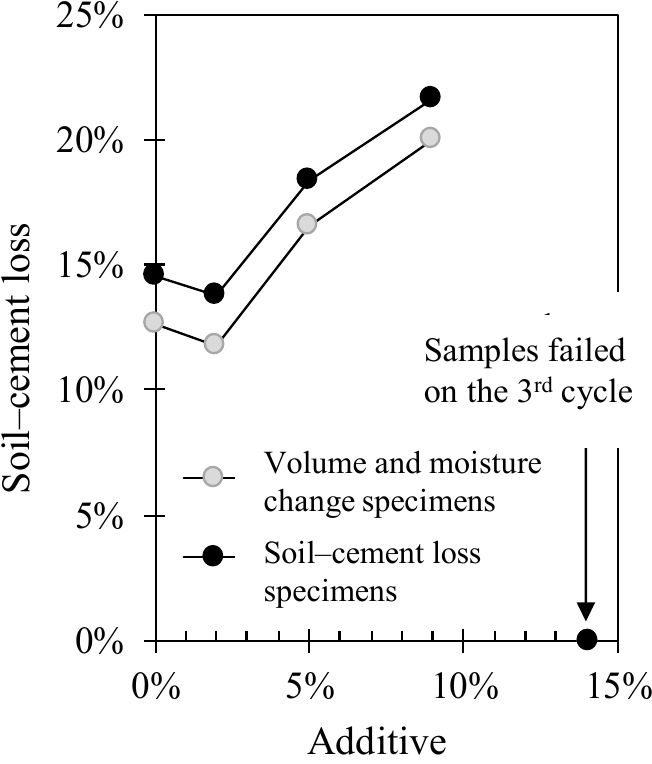
Figure 13. Soil–cement loss as a function of the additive content of lateritic soil. 314